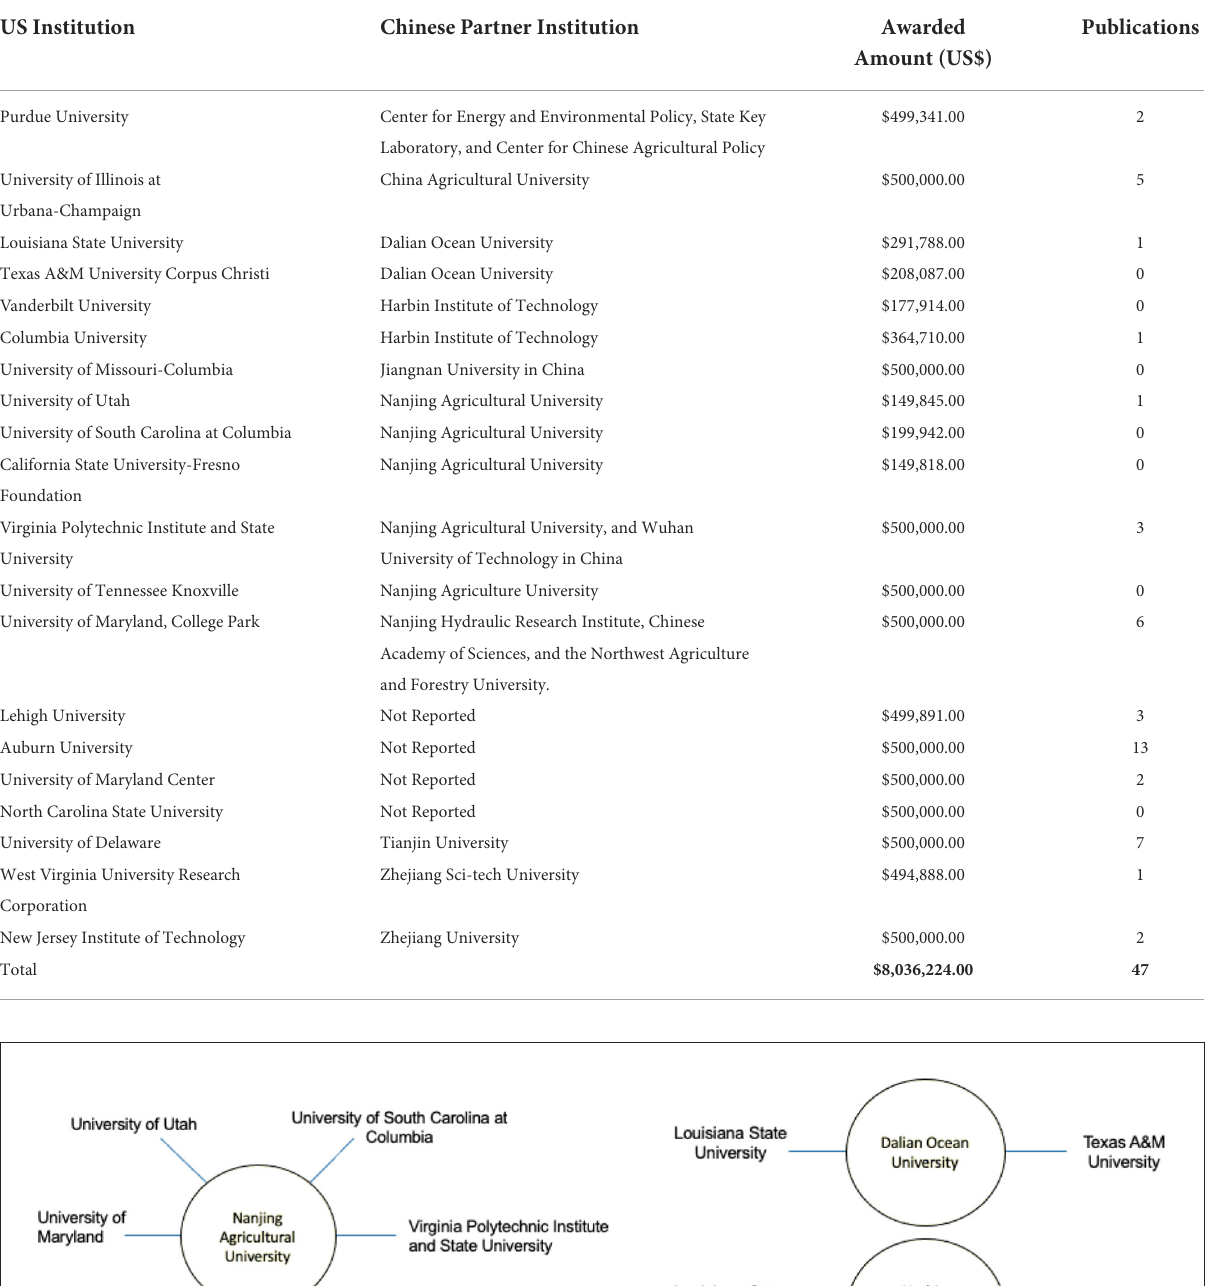
TABLE 2 InFEWS US-China projects funded by NSF (information extracted through the NSF webpage).